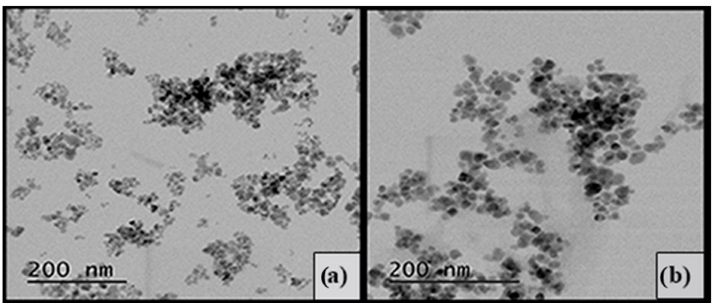
Figure 2. TEM image of uncovered MNP ( a ) and magnetic nanostructure MNP@PAAA-FA ( b ) measured using a 10 µ L deposited drop of a suspension of each sample that was dried on a copper grid coated with a thin carbon film.